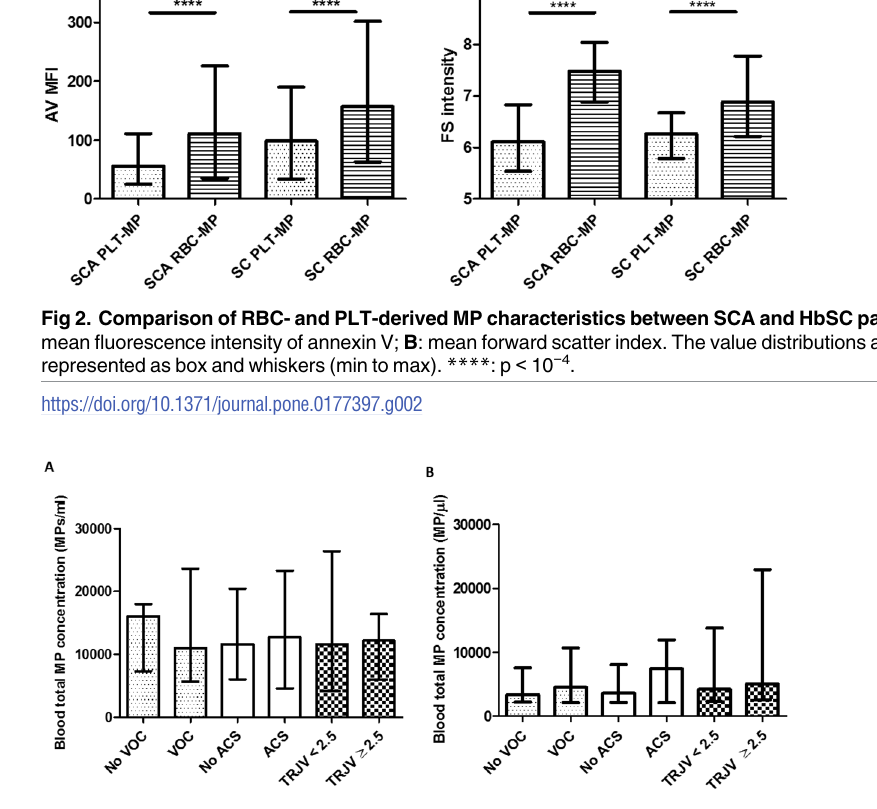
Fig 3. Comparison of total MP concentrations between not HC-treated SCA and HbSC patients classified according to the occurrence of VOC, ACS and abnormal TRJV. A : Not HC-treatedSCA childrenclassified accordingto VOC, ACS and TRJV (cid:21) 2.5 m/s occurrences respectively. B : HbSC children classifiedaccordingto VOC ACS and TRJV (cid:21) 2.5 m/s occurrences respectively. Blood total MP concentrations are representedas medianwith interquartile range.